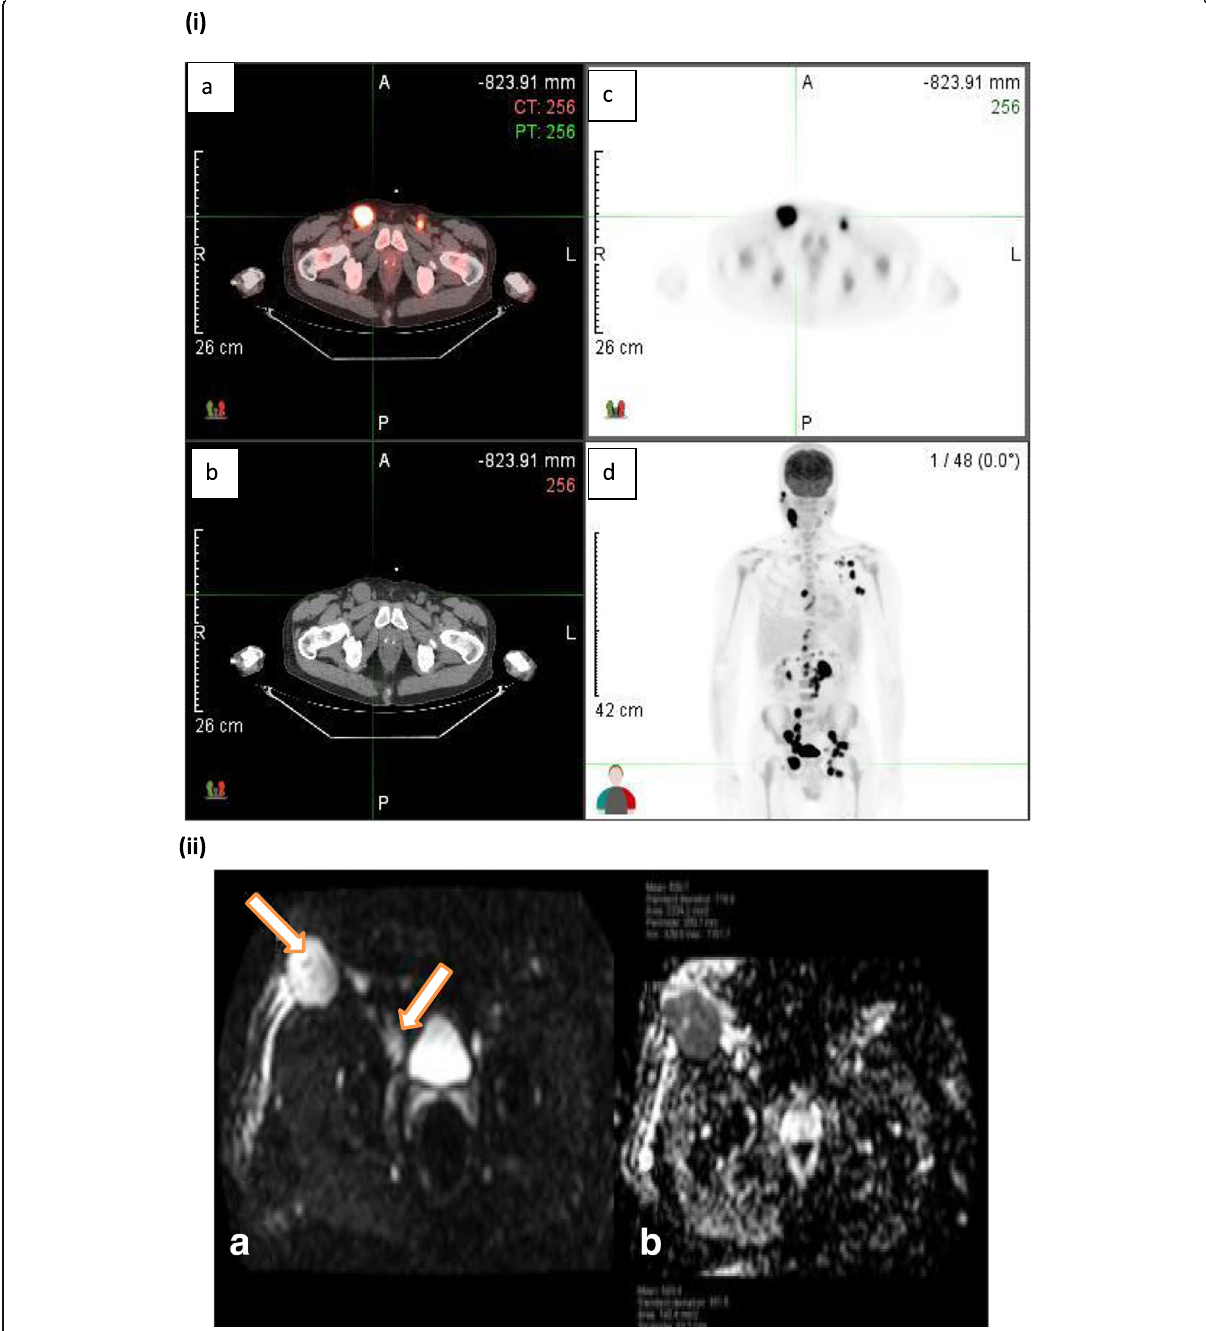
Fig. 1 A 59-year-old male with histopathologically proven lymphoma. (i) Axial PET/CT fused image ( a ), axial CT ( b ), and axial PET ( c ) of the inguinal region and coronal MIP PET ( d ) showed multi-station FDG avid lymphadenopathy consistent with lymphoma with average SUV max 12.4. (ii) Axial DWIBS ( a ) and ADC map ( b ) of the same patient showed restricted diffusion at right inguinal and right external iliac lymph